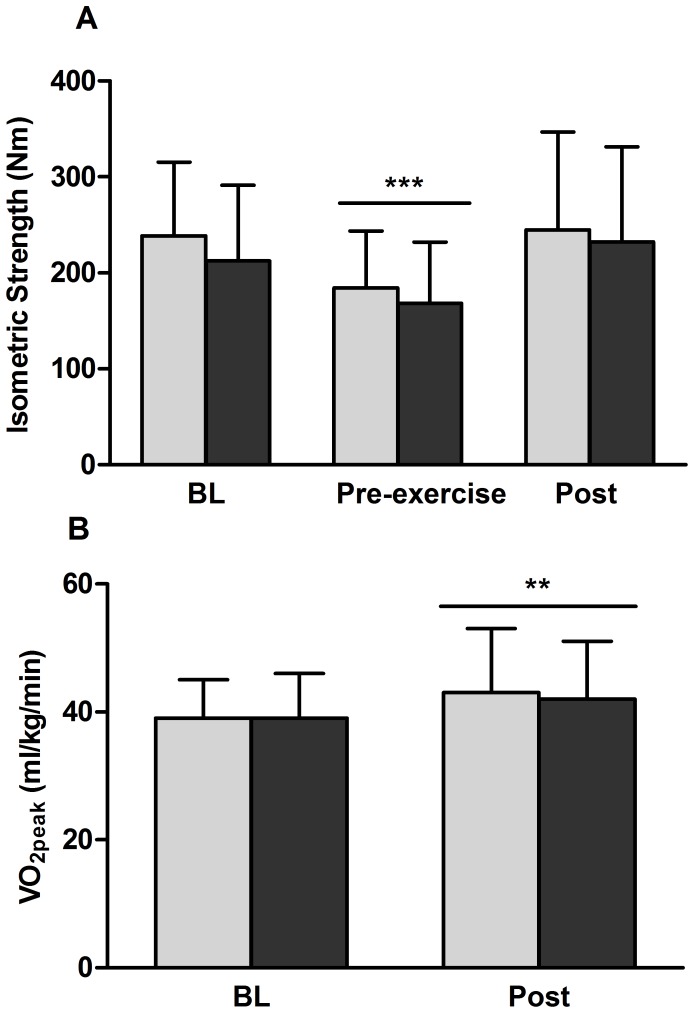
Concurrent exercise recovers maximum isometric strength loss induced by disuse and increases aerobic performance.A - Values for maximum isometric strength of the knee extensors before immobilization (BL), before exercise (pre-exercise) and after 6 weeks of rehabilitative concurrent exercise (Post). B - peak oxygen consumption (VO2peak) before immobilization (BL) and after 6 weeks of concurrent exercise (Post). Light bars indicate END>RES group, dark bars indicate RES>END group. **Significant difference from baseline (P<0.01). ***Significant difference from baseline (P<0.001). Bar indicates main effect for time and not exercise group. Mean ± SD.